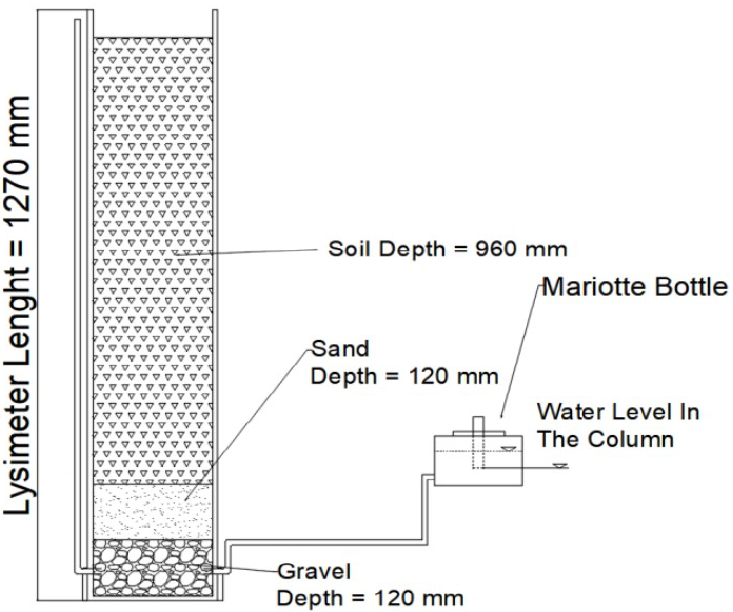
Figure 1. Schematic diagram of lysimeter and Mariotte bottle system to control water table depth.